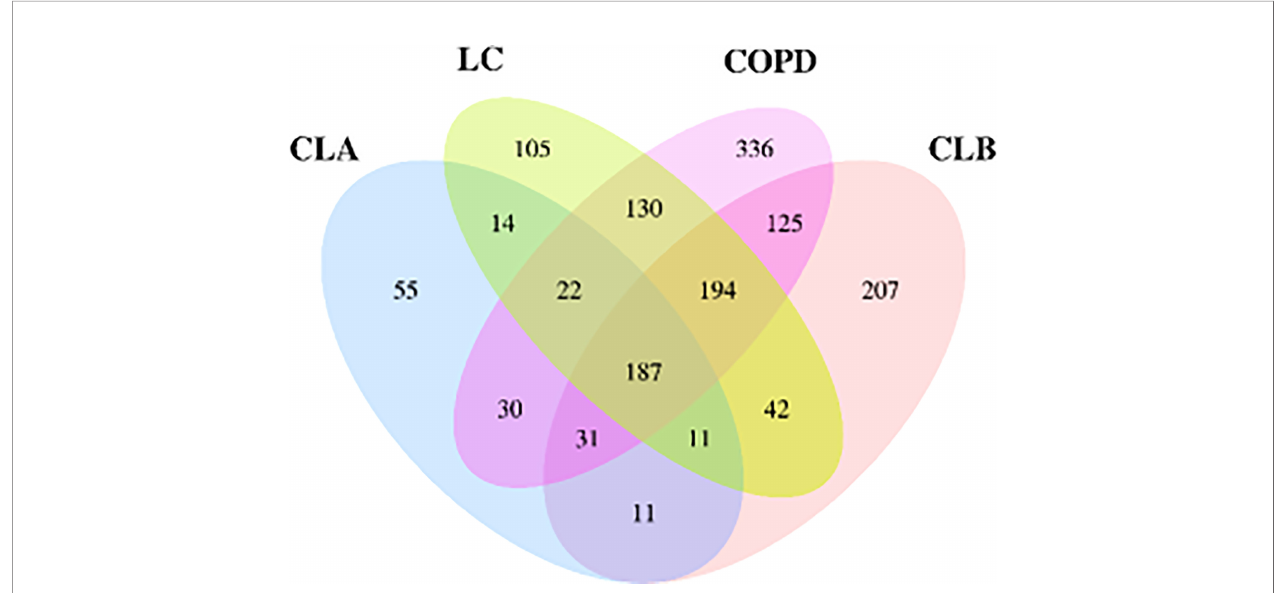
FIGURE 1 | Veen diagram of the number of shared and unique operational taxonomic units (OTUs) among the CLA (surgical treatment), CLB (non-surgical treatment), LC (lung cancer), and COPD (chronic obstructive pulmonary disease)